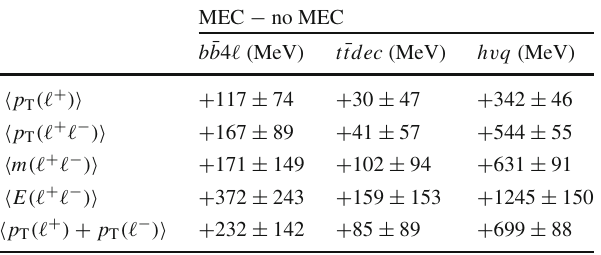
Table 22 Extracted B coefficients for the three different generators showered with